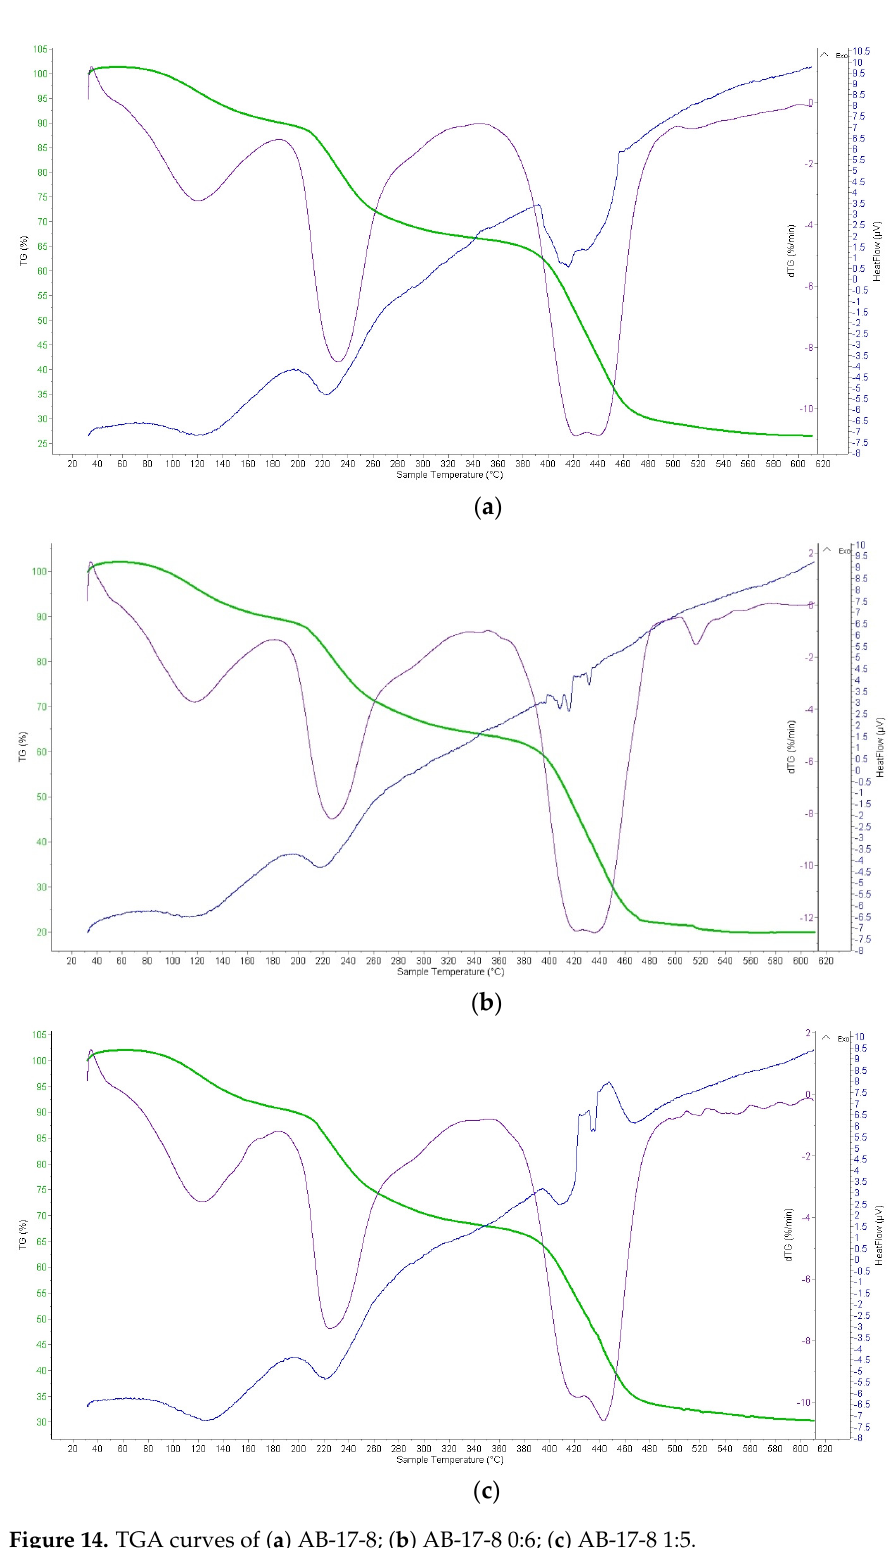
Figure 14. TGA curves of ( a ) AB-17-8; ( b ) AB-17-8 0:6; ( c ) AB-17-8 1:5. Figure 15 represents a comparison of thermal destruction curves (mass loss (a) and rate of mass loss (b)) of individual AB-17-8, AB-17-8 from ratio 6:0 and AB-17-8 from ratio 1:5. A difference in loss of mass of the 3 samples of AB-17-8 is observed from 200 ° C, before this temperature it occurs simultaneously. Strong mass loss from 375 ° C to 450 ° C points to thermal decomposition of the ion-exchange structure, differences in the values of the mass loss are due to sorption of europium ions by the macromolecule. The temperature area from 450 ° C to 625 ° C is accompanied with a slight decrease of the mass loss due to the stabilization of the thermal destruction process.